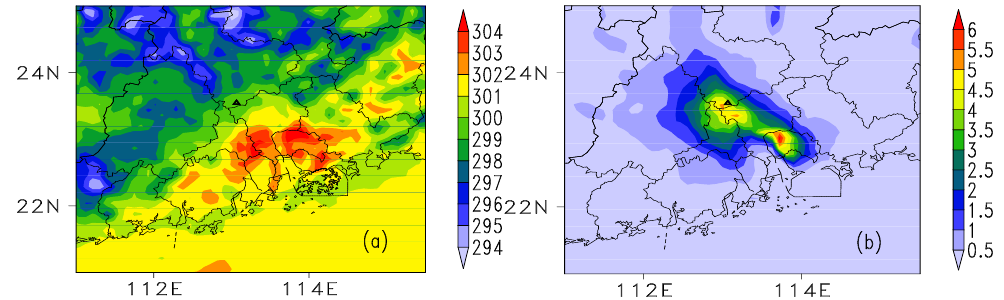
Figure 5. Surface distribution of 1400 local time (LT) ( a ) temperature (unit: K) and ( b ) reaction rate of C 2 O 3 + NO 2 → PAN (unit: ppbv) in Pearl River Delta (PRD). The black triangle highlights the position of the backgarden site (BGS). Atmosphere 2018 , 9 , x FOR PEER REVIEW 11 of 16